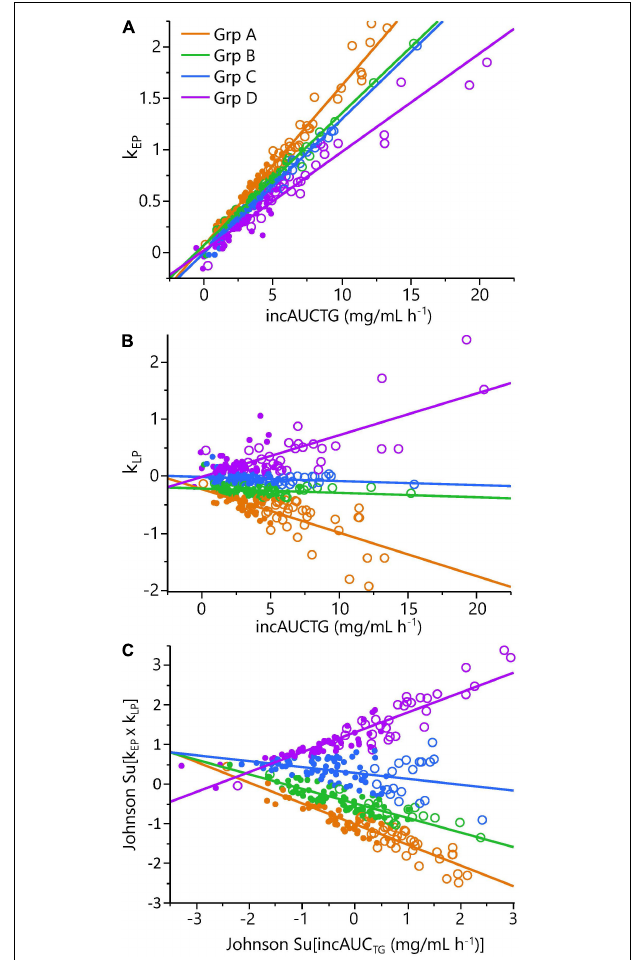
FIGURE 5 | Phenotyping cohort postprandial triglyceride kinetic analysis demonstrated significant phenotypic variance. Panels show: (A) the triglyceride rate of change in the 0 to 3 h early phase (k EP ) as a function of the incremental area under the triglyceride curve (incAUC TG ); (B) the triglyceride rate of change in the 3 to 6 h late phase (k LP ) as a function of the incAUC TG ; (C) A Johnson-normalized k EP x k LP product as a function of the Johnson-normalized incAUC TG . The quartiles of the Johnson Su [(k EP x k LP )/incAUC TG ] defined four kinetic response groups (A-D): Group A – early-phase increase/substantial late-phase decrease (orange; n = 86); Group B – early-phase increase/minimal late-phase decrease (blue; n = 83); Group C – early-phase increase/no late-phase decrease (green; n = 85); Group D – early-phase increase/late-phase increase (purple; n = 84). Note, quartiles do not have the same number of participants due to a small percentage of individuals with identical values. The Johnson Su [(k EP x k LP ) / incAUC TG ] and